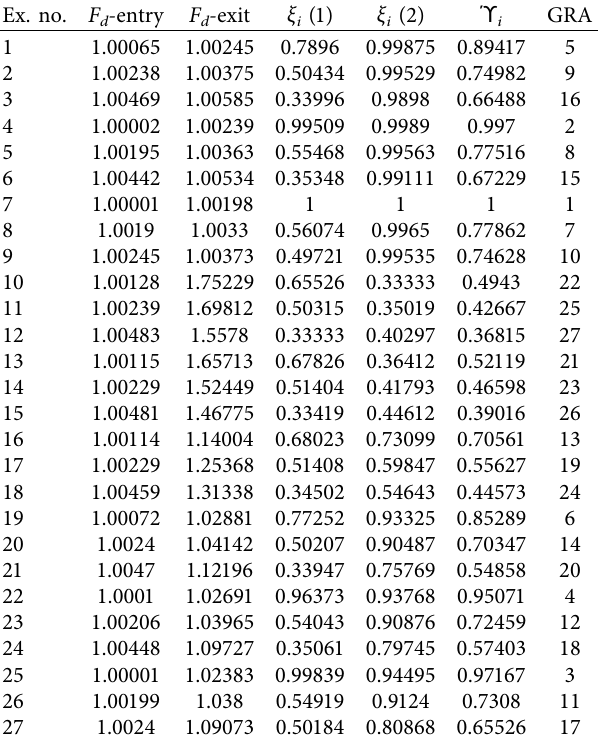
Table 6: Grey relational analysis for delamination.